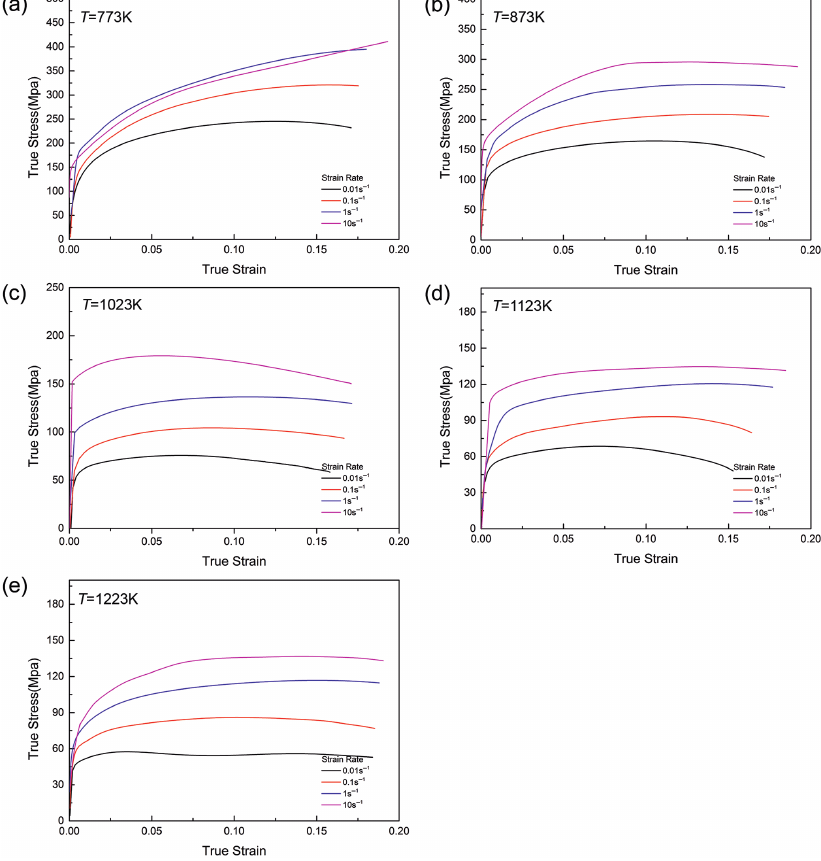
Figure 4: The true stress – strain curves at different deformation conditions: (a) T = 773K, (b) T = 873K, (c) T = 1,023K, (d) T = 1,123K, (e) T =